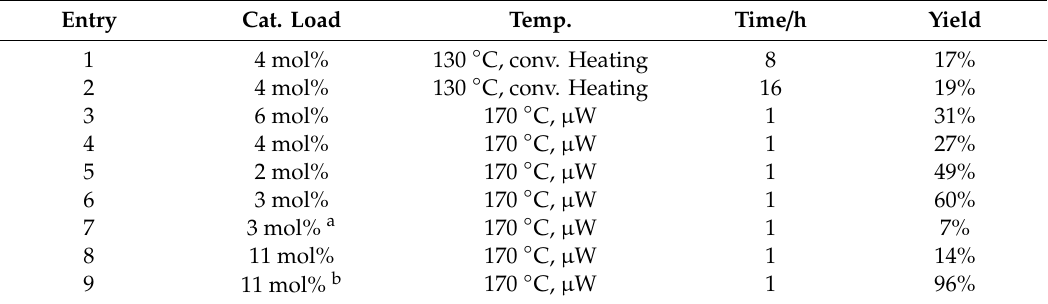
Table 2. Overview of the Stille-Kelly reaction optimization for the di-stannylated azobenzene 8 . Entry Cat.